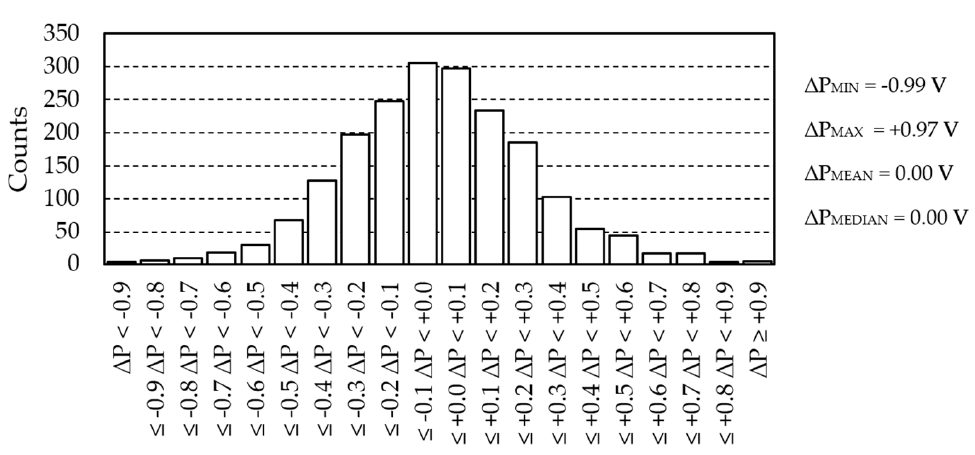
Figure 9. Load changes in the random group.